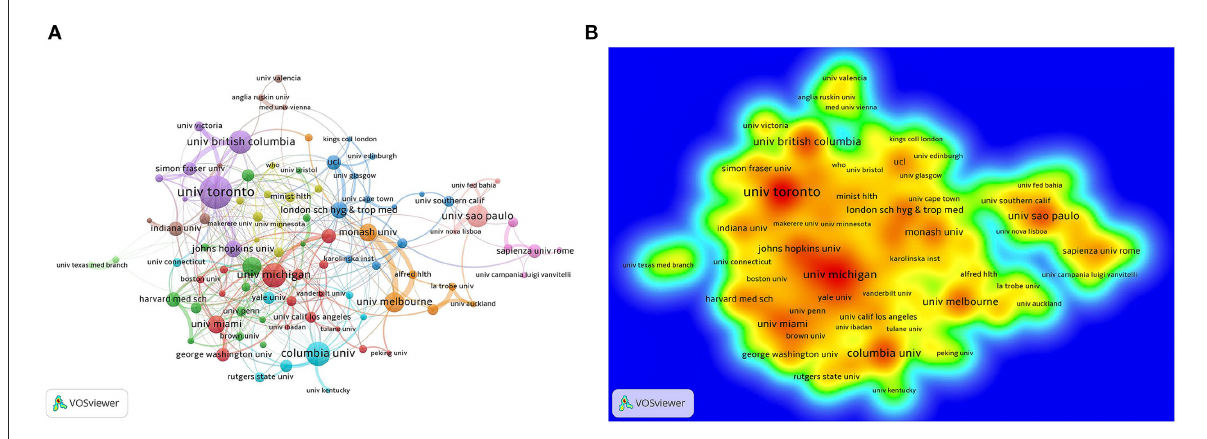
FIGURE3 Contributions of different institutions to publications. (A) Cooperation network visualization between institutions. The size of the node indicates the number of publications and different colors represent different clusters. (B) Density map of institutions.